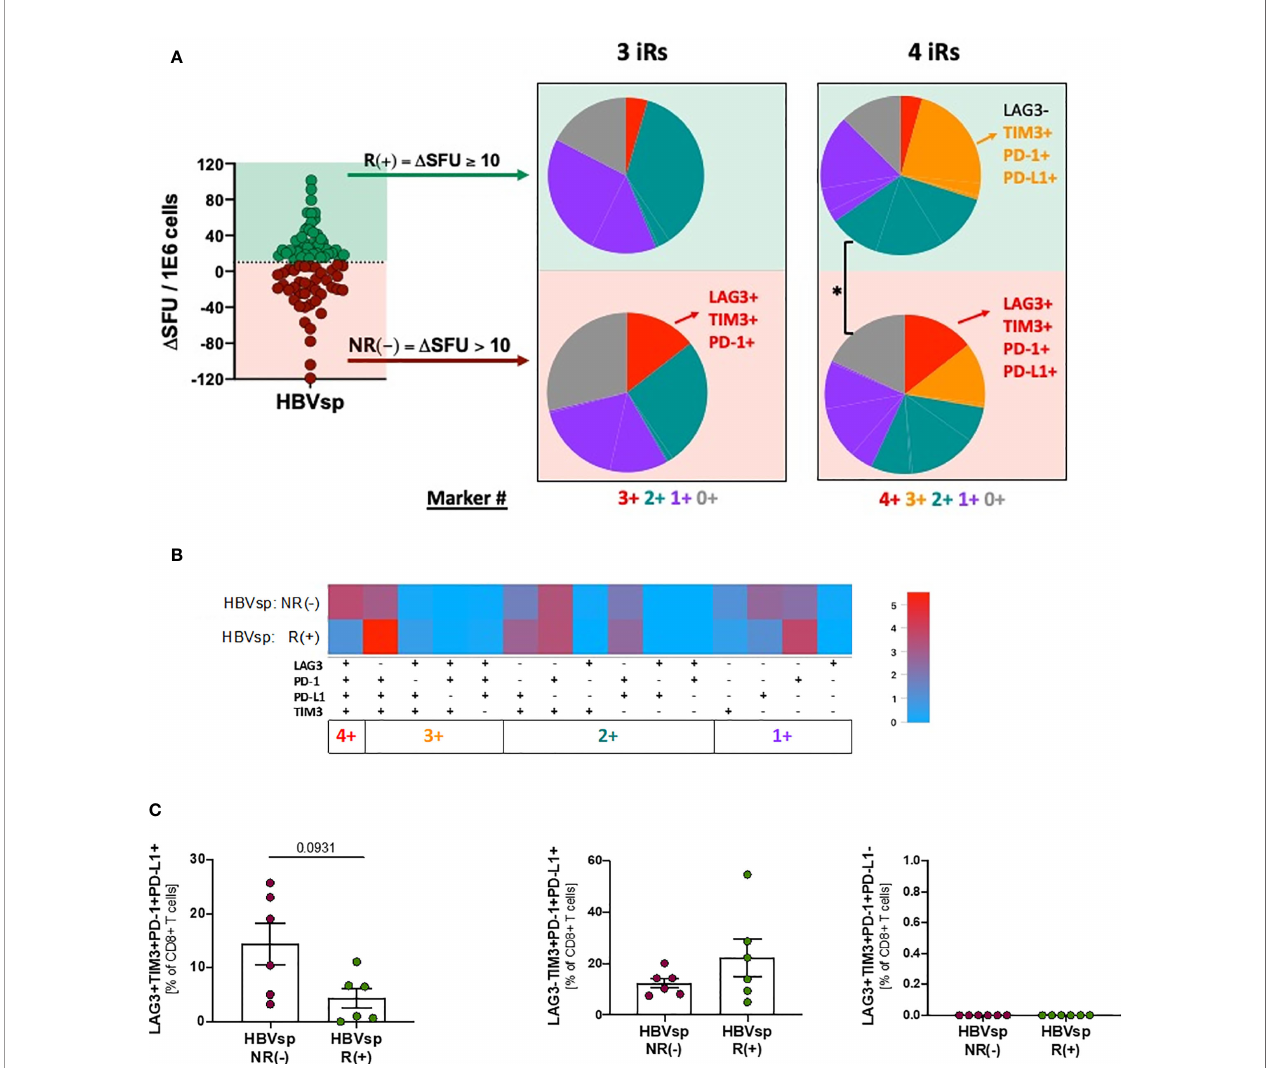
FIGURE 5 | Highly exhausted HBV-speci fi c CD8 T cells do not respond to PD-L1 blockade. Frequency of HBV-speci fi c (core and/or pool) CD8 T cells with phenotype consistent with low exhaustion (LAG3-TIM3-PD-1+PD-L1-; 1 + markers); intermediate exhaustion LAG3-TIM3+PD-1+PD-L1±; 2+/3+ markers) and high exhaustion (LAG3+TIM3+PD-1+PD-L1+; 4 + markers) between responders (R) and non-responders (NR) to PD-L1 blockade shown as (A) SPICE analysis. *p < 0.05; Permutation test, (B) SPICE CoolPlot and (C) pooled data. Mann Whitney